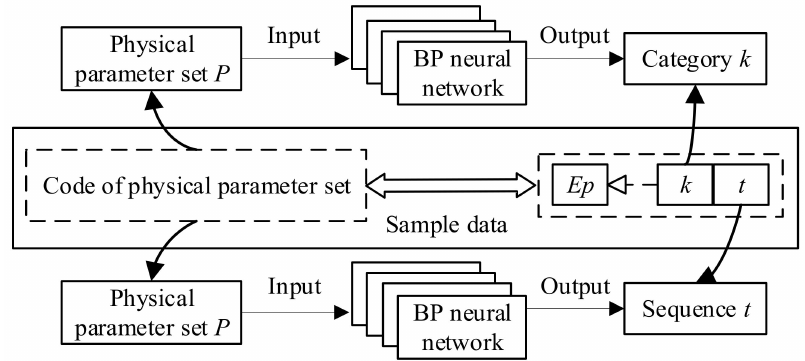
Figure 6. Training method of the mapping model.